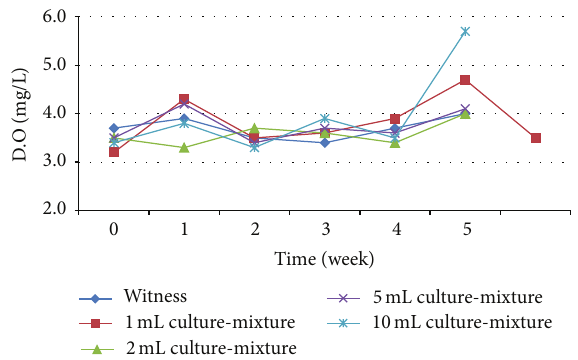
Figure 6: Dissolved oxygen results in the filtrate.